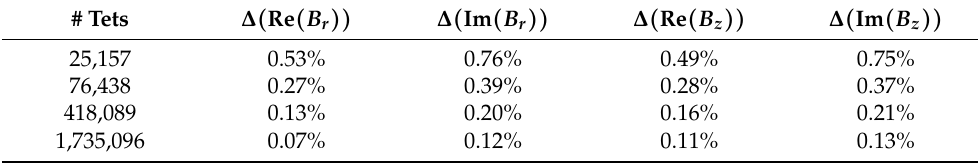
Table 5. Discrepancy between 3D CM–BEM with ACA compression and third ord. 2D